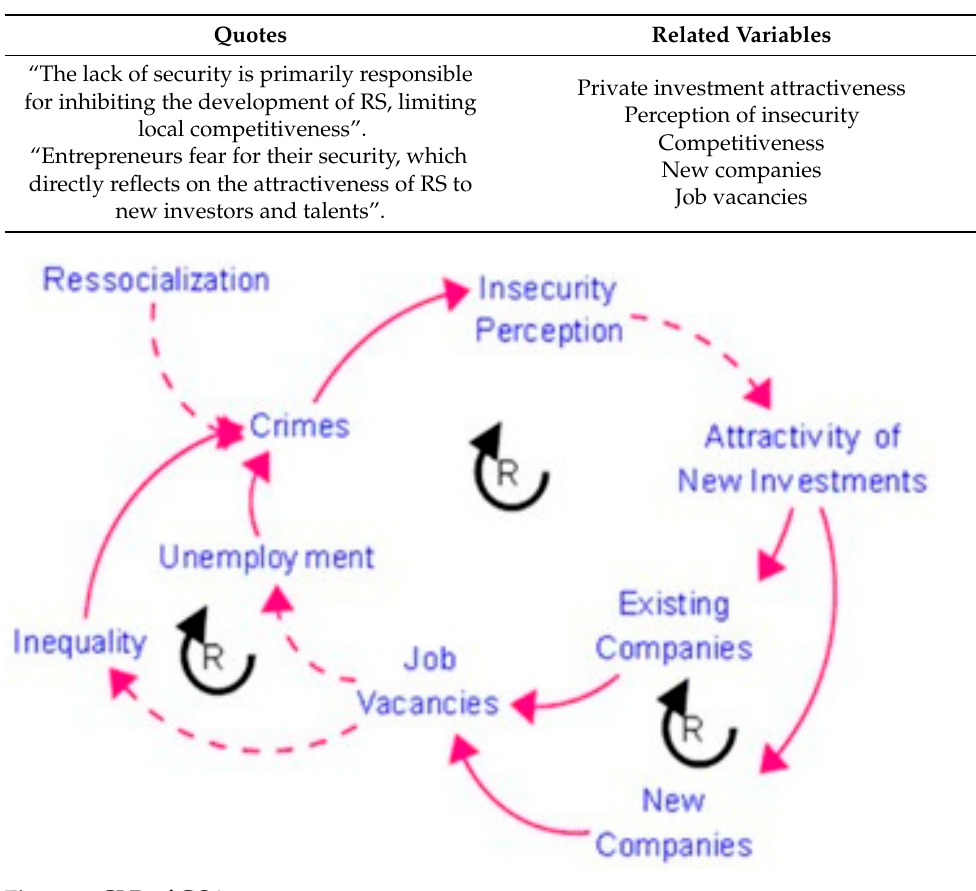
Figure 2. CLD of Figure 2. CLD of GQ1.